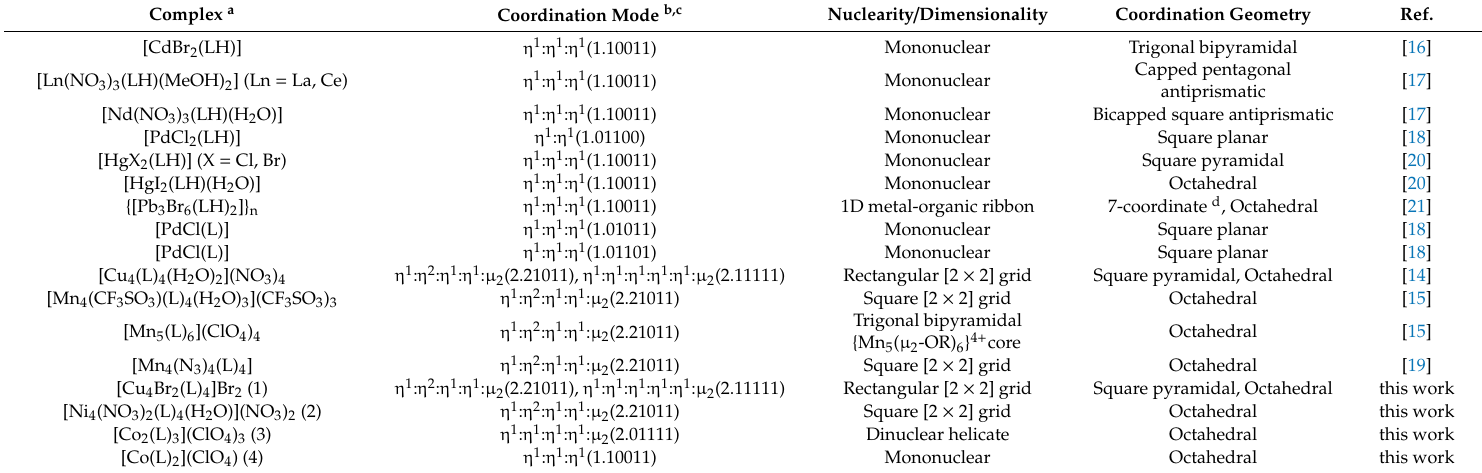
Table 5. To date crystallographically characterized metal complexes of LH and L − , and relevant structural